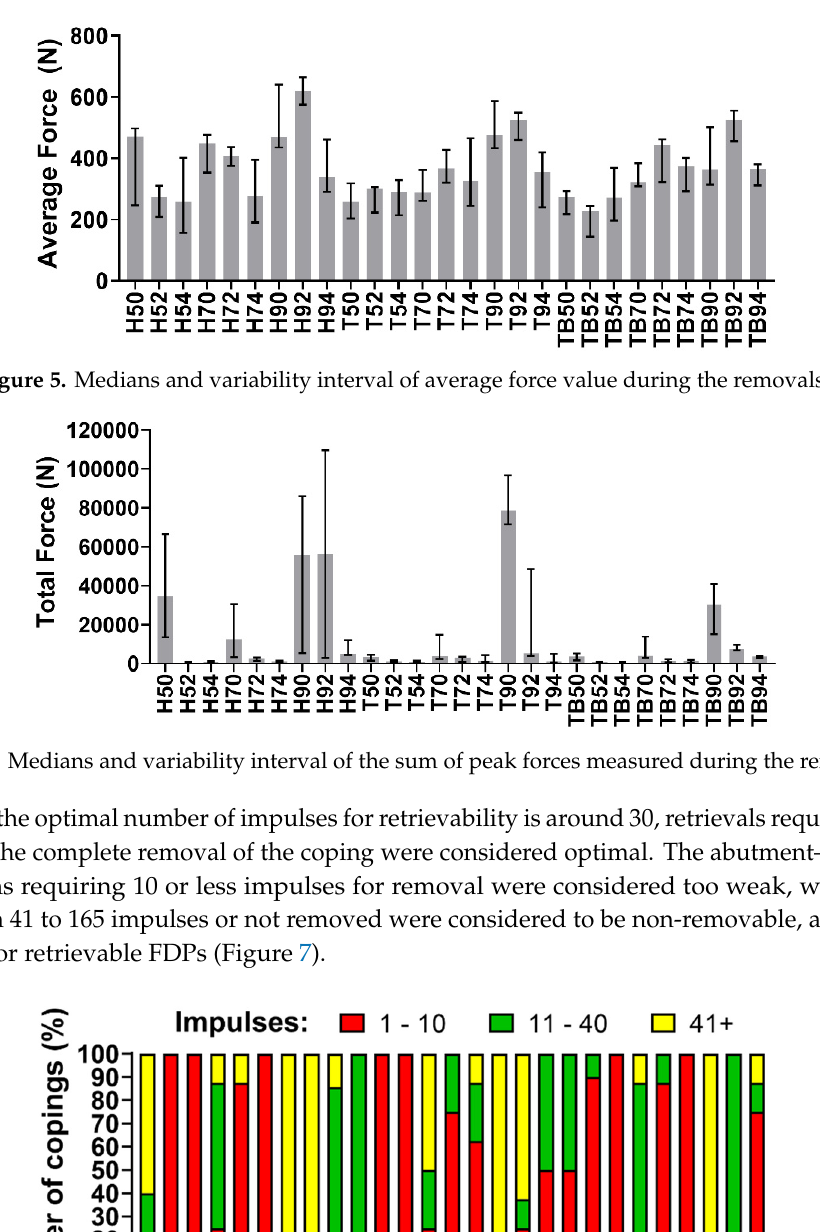
Figure 4. Medians of the number of impulses required for removal. The error bars represent the variability interval between the 25th and the 75th percentiles of each data group.